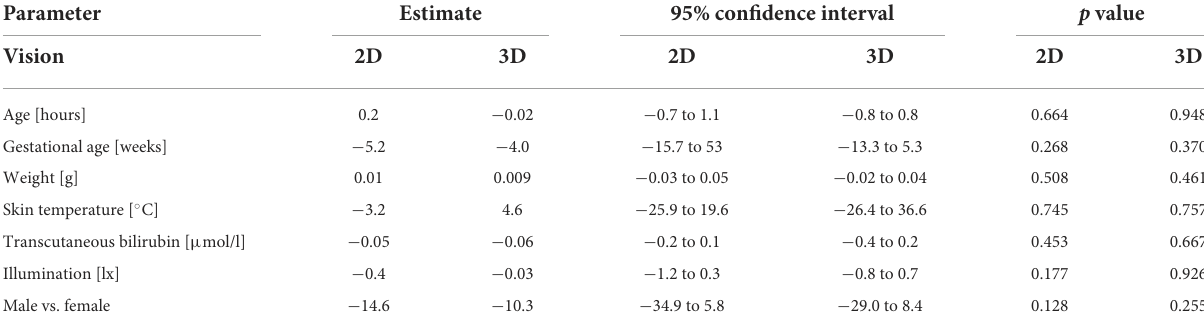
TABLE 3 Effects of demographic and clinical characteristics on the accuracy of the heart rate measurements.